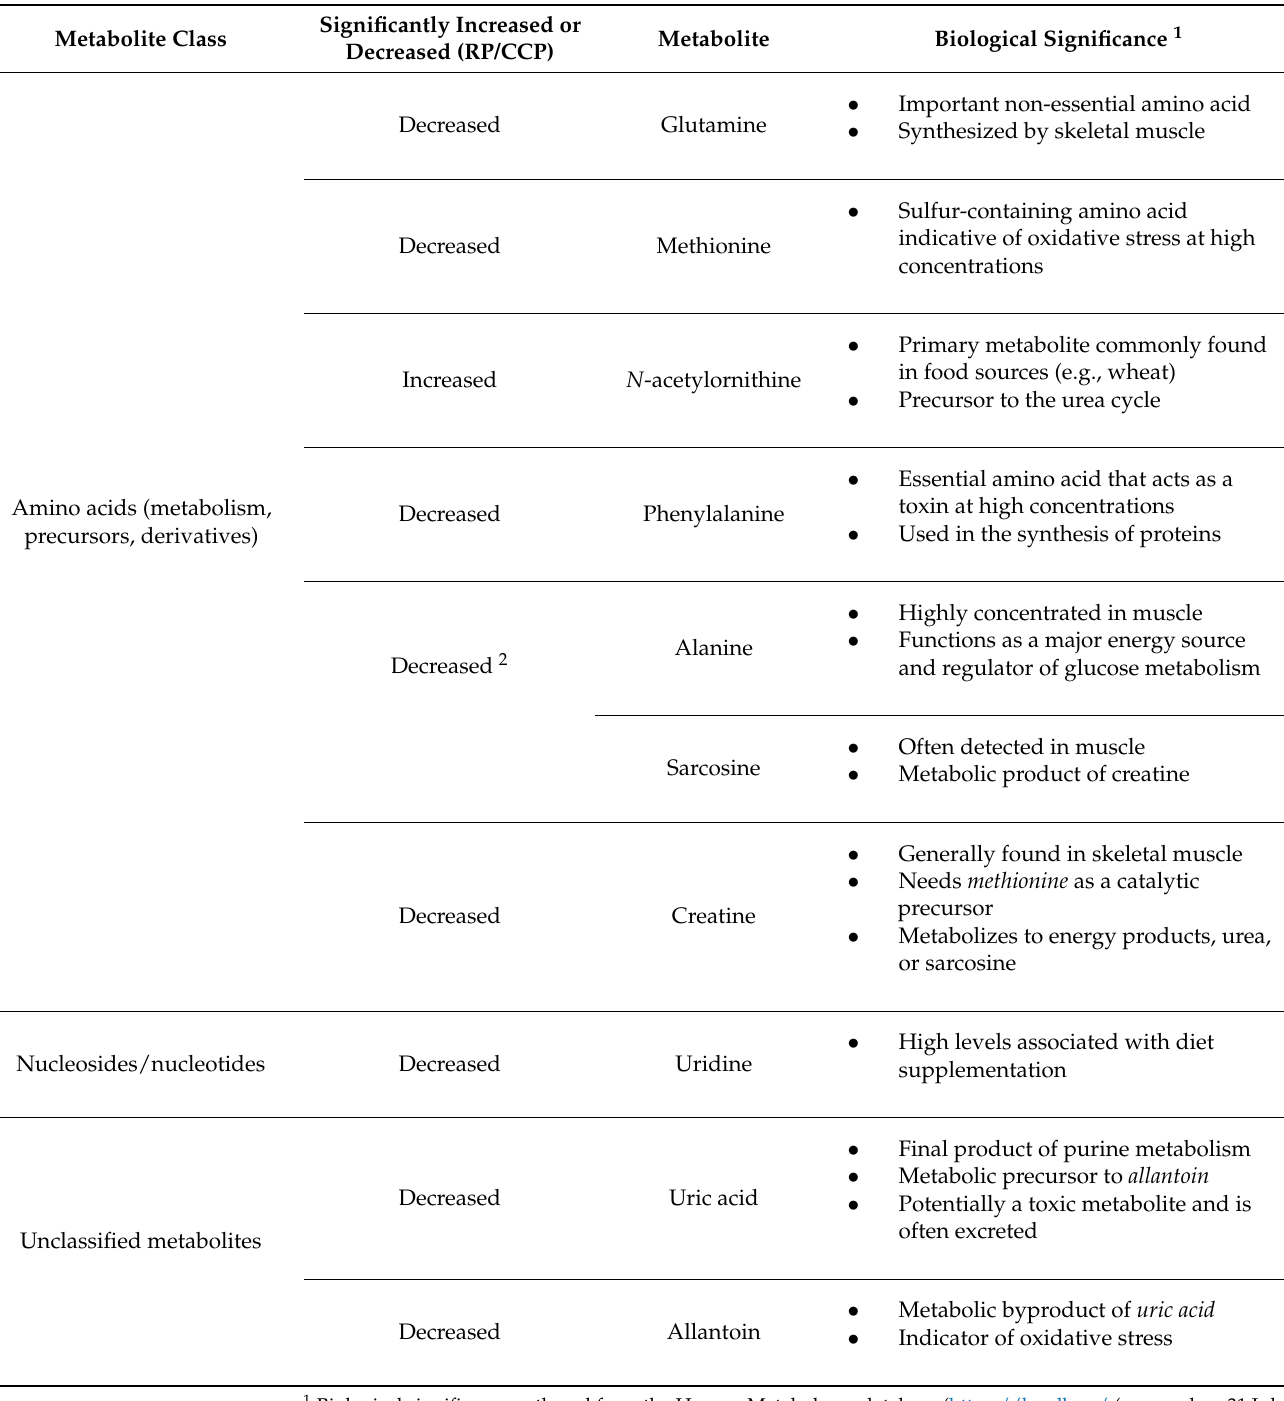
Table 5. Biological significance of metabolites observed to have significantly increased or decreased between the RP and the